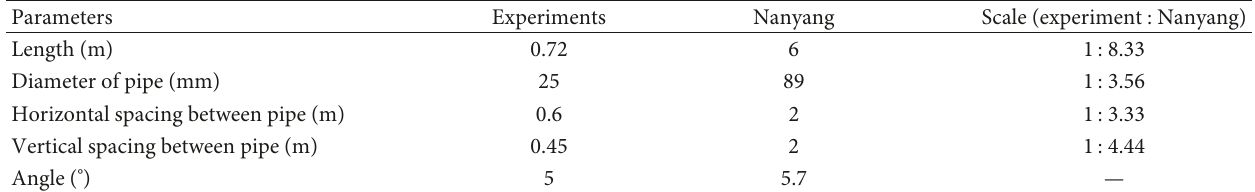
Table 2: Scale factor between pipes in this study and